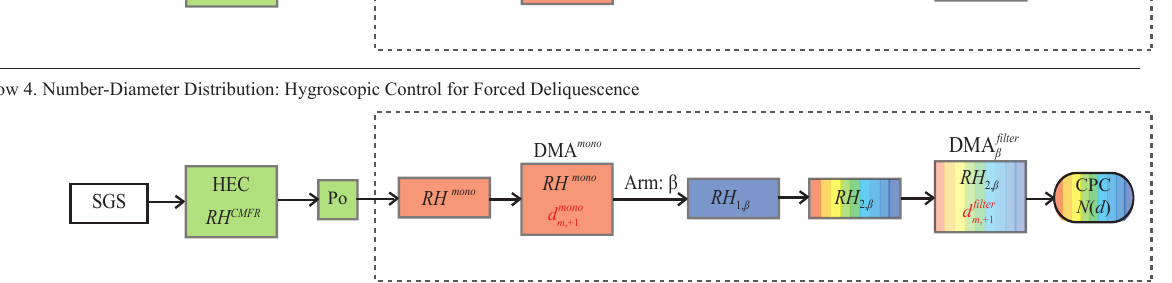
Fig. 1. Schematic diagram of the experimental setup for the transmission ratio and number–diameter distribution measurements. Labeled components include the sulfate seed particle generation system (SGS), the Harvard Environmental Chamber (HEC), a polonium-210 charger (Po), relative humidity (RH) adjustments in Nafion tubes, differential mobility analyzers (DMA), and condensation particle counters (CPC). The background color shading of each component represents the local relative humidity (see color bar). Rainbow shading within a single component indicates that the relative humidity is scanned during the measurements. The gray dashed boxes enclose the components that comprise the